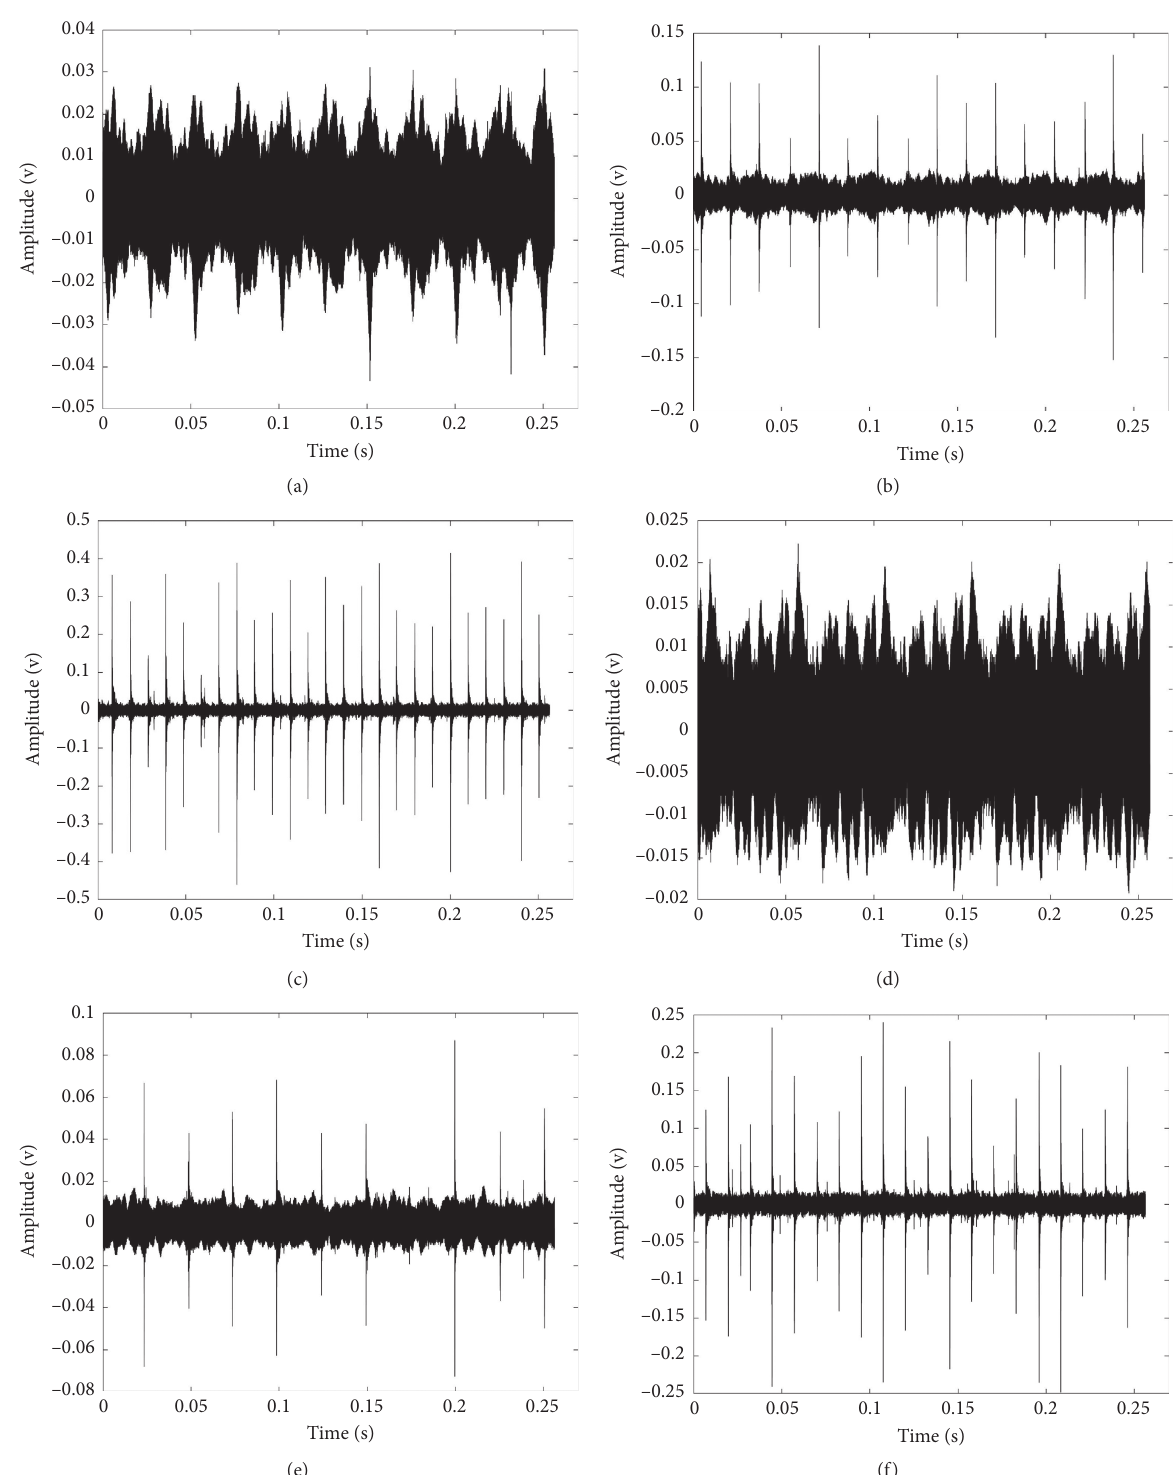
Figure 7: (a) Small defect, small load, and 600rpm. (b) Small defect, medium-low load, and 900rpm. (c) Small defect, medium-high load, and 1500rpm. (d) Large defect, small load, and 600rpm. (e) Large defect, medium-high load, and 600rpm. (f) Large defect, high load, and